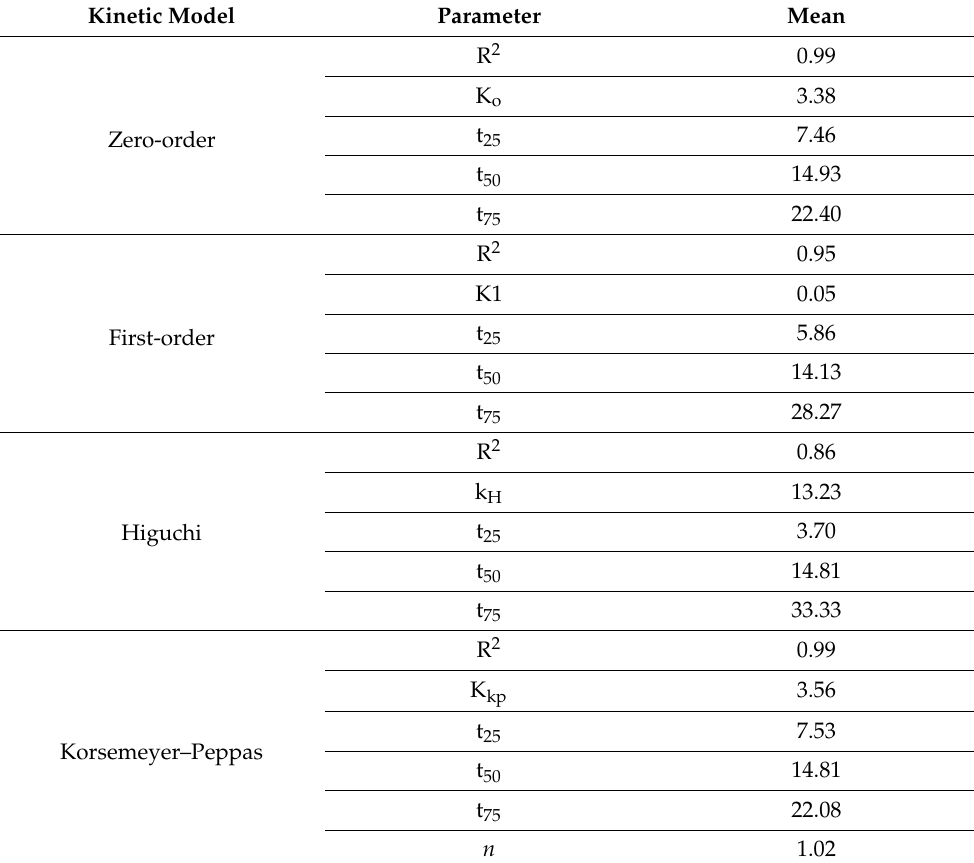
Table 2. Analysis of release data using kinetic